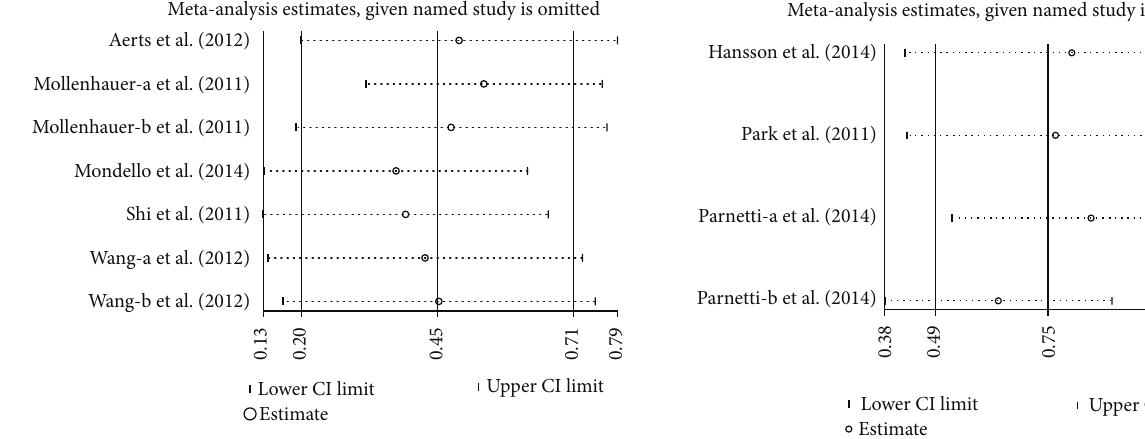
Figure 9: Sensitivity analysis of CSF 𝛼 -syn levels in PD compared to MSA.